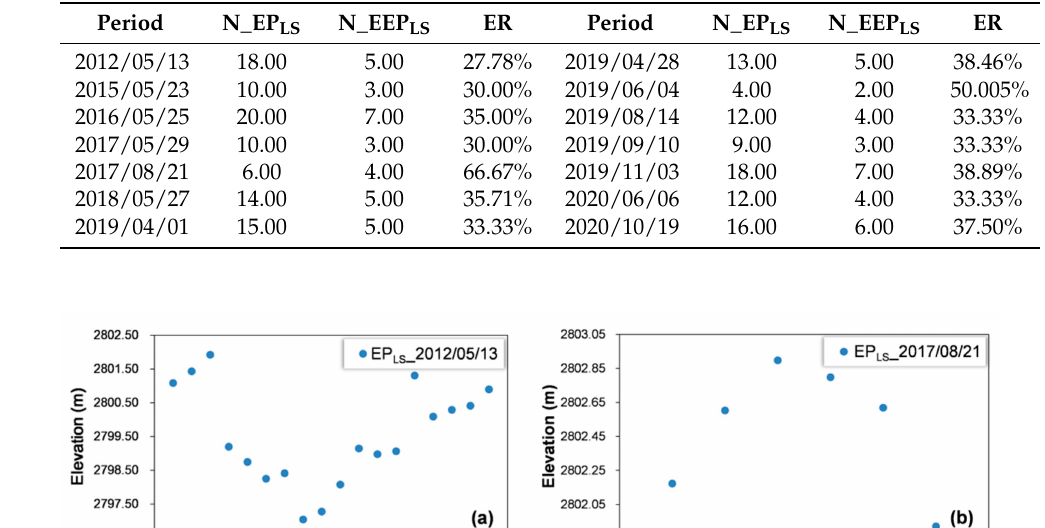
Figure 7. ( a ) Initial water level and ( b ) water level extracted by the algorithm of Gahai Lake. Table 4. Elevation of lake surface during the period over which the water level deviated.